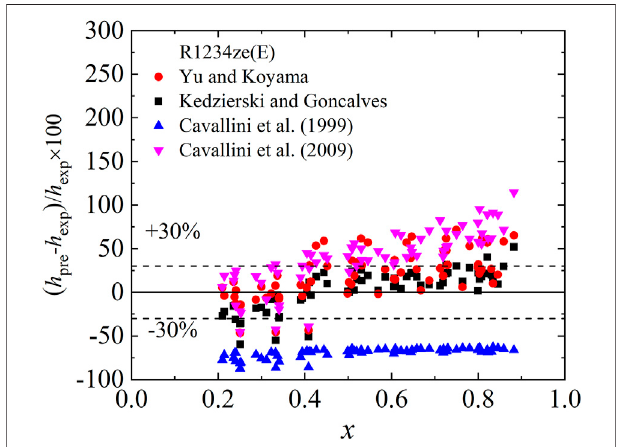
FIGURE 6 | Comparison of predicted and experimental heat transfer coef fi cients.